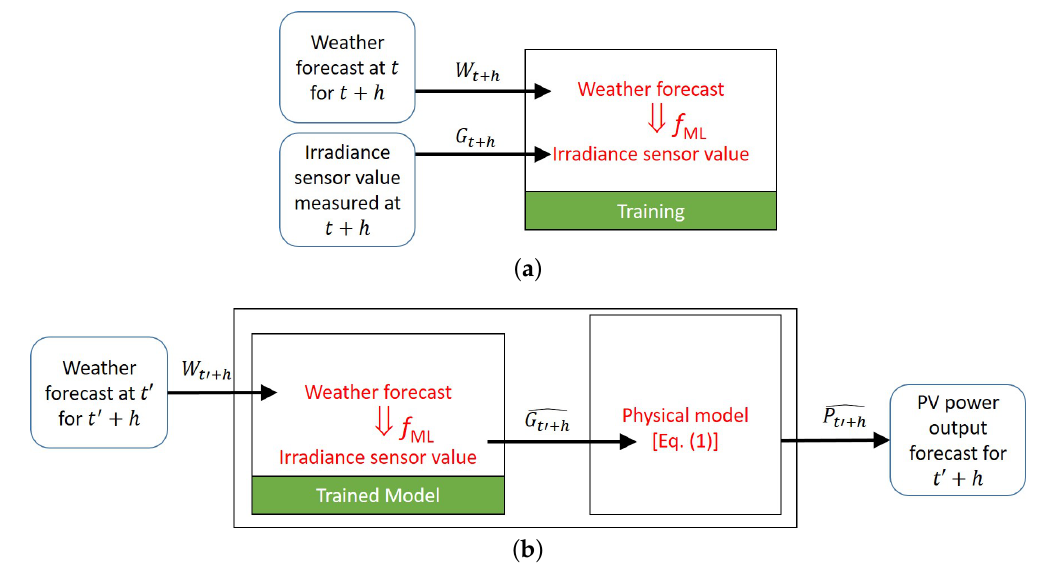
Figure 7. Conventional approach to forecasting PV power output: ( a ) training; ( b );